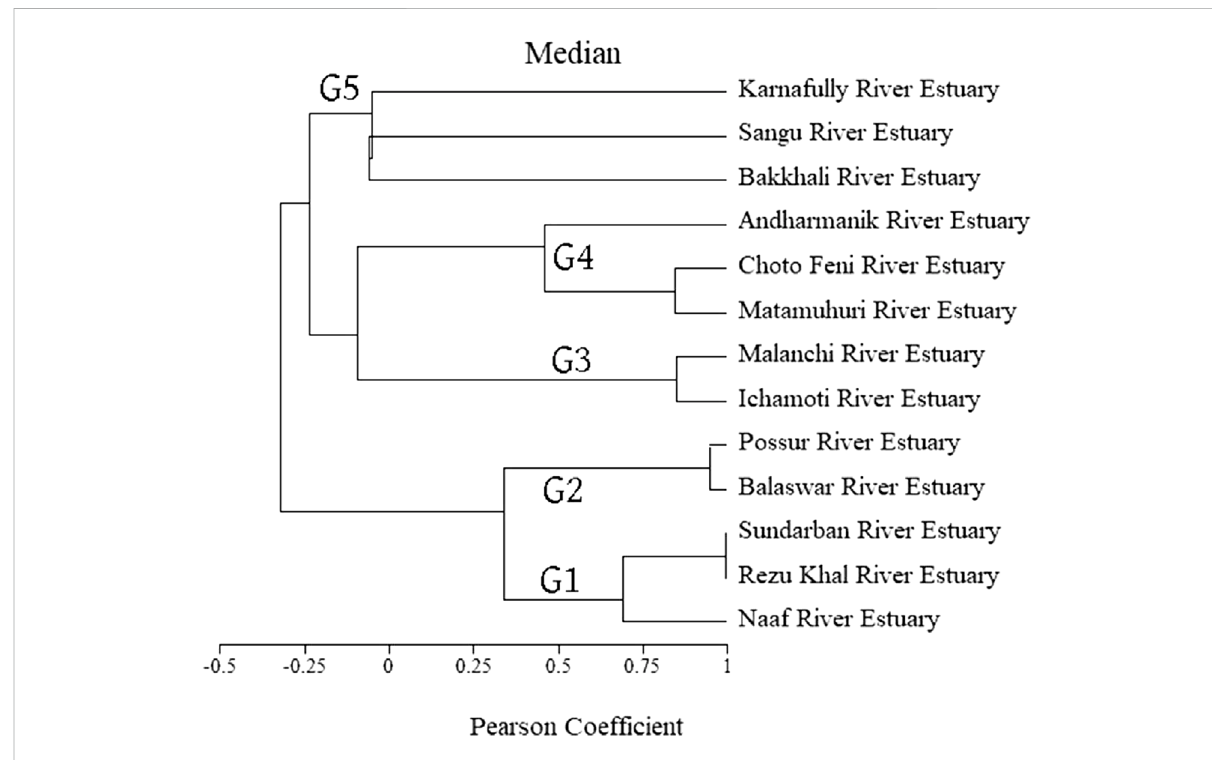
FIGURE 7 Cluster analysis of all estuaries in different groups (G) by considering different hydrobiological variables with Pearson coef fi